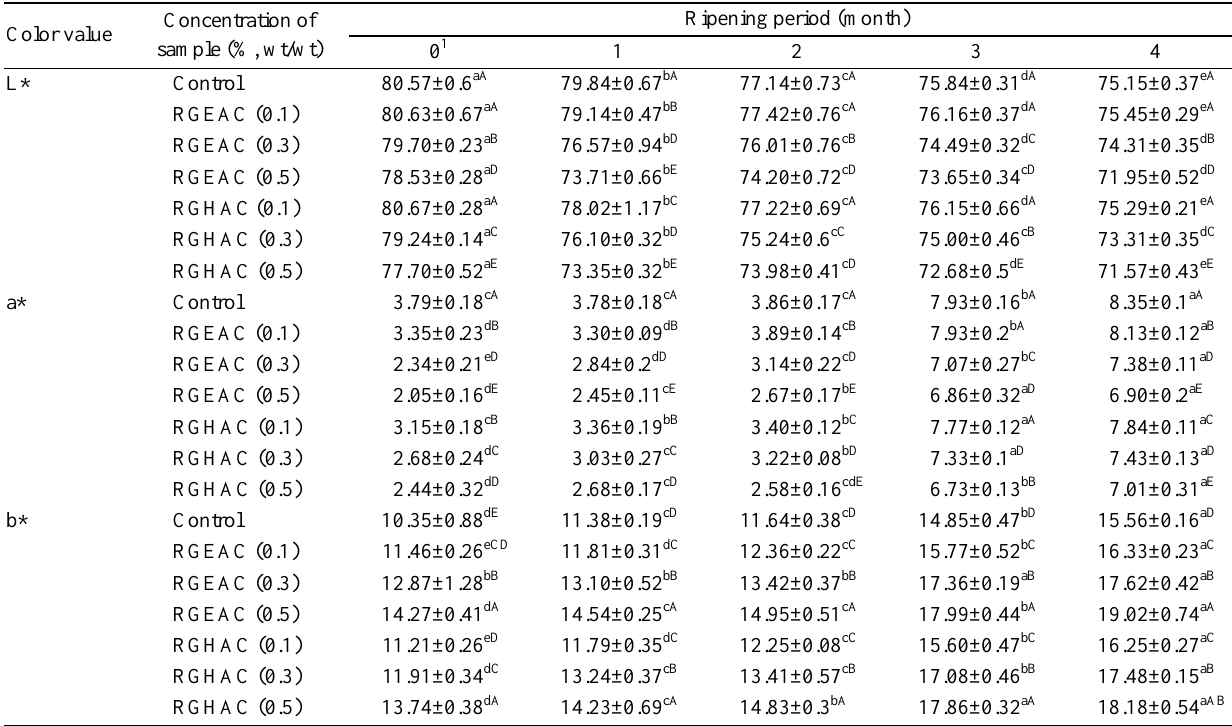
Table 4. Changes in color of red ginseng hydrolyzate- or red ginseng extracts-added Asiago cheese ripened at 14°C for 4 months Concentration Color value